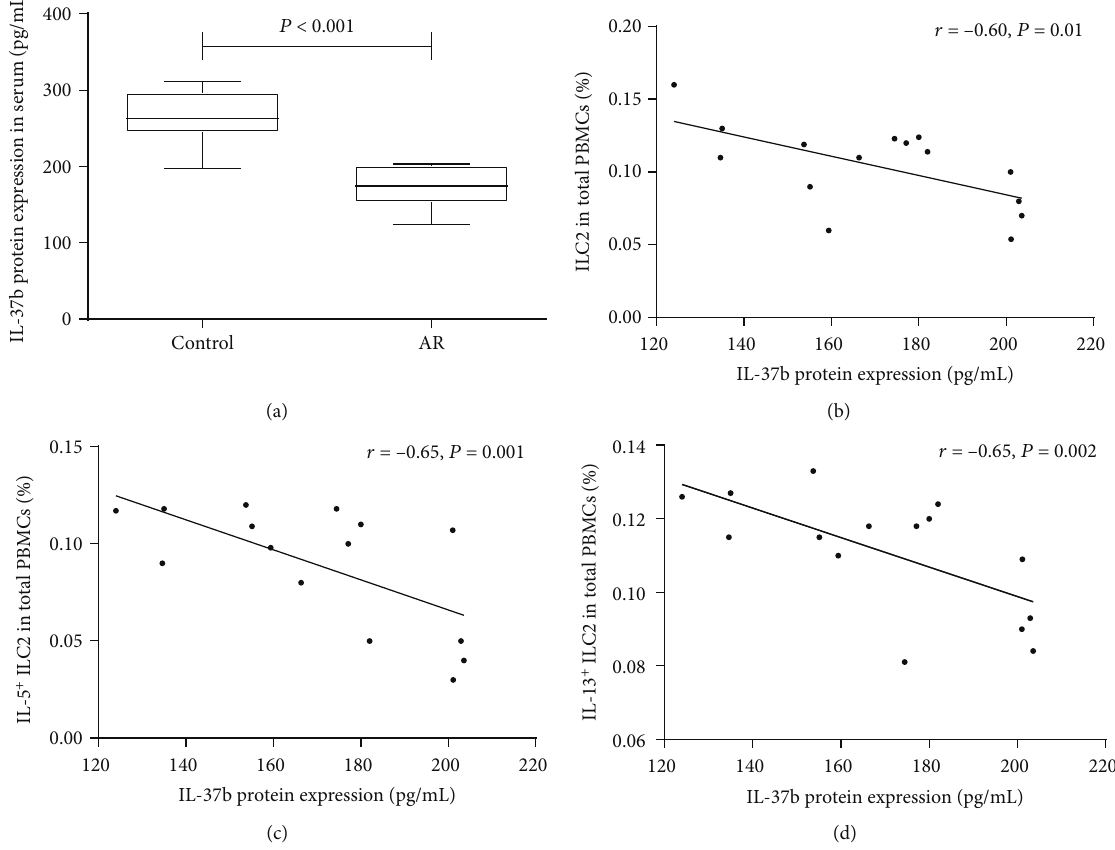
Figure 2: Correlation between IL-37b protein expression and the proportion of ILC2, IL-5+ILC2, and IL-13+ILC2 cells in AR. (a) The IL- 37b protein expression between control and AR. (b – d) Negative correlation between IL-37b protein expression and the proportions of ILC2, IL-5+ILC2, and IL-13+ILC2 in AR. AR: allergic rhinitis; ILC2: type 2 innate lymphoid